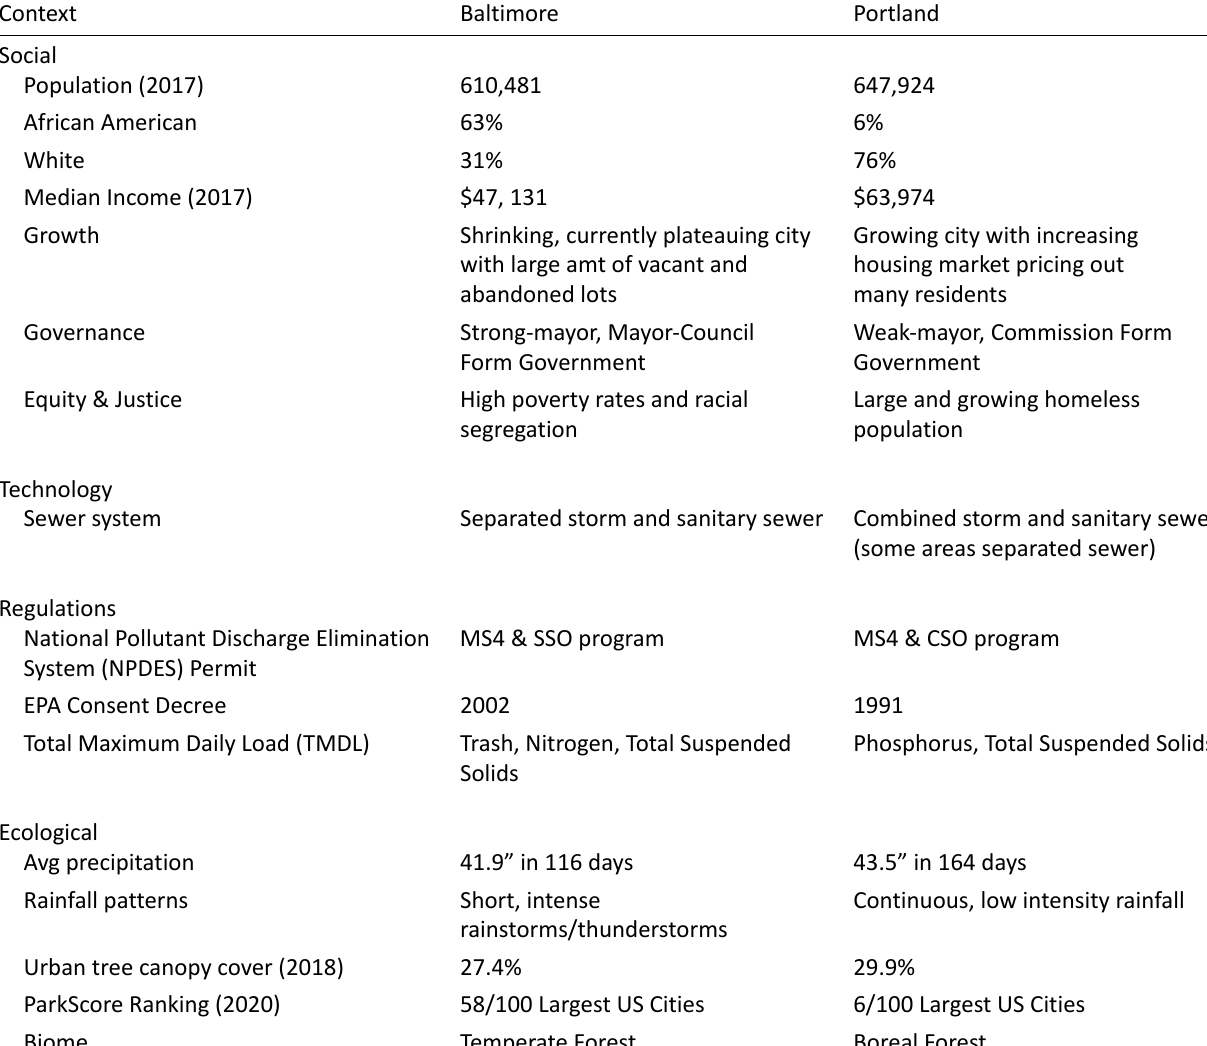
Table 1. Case study SETS characteristics, highlighting two long-term GI programs in different social, ecological, and technical contexts.